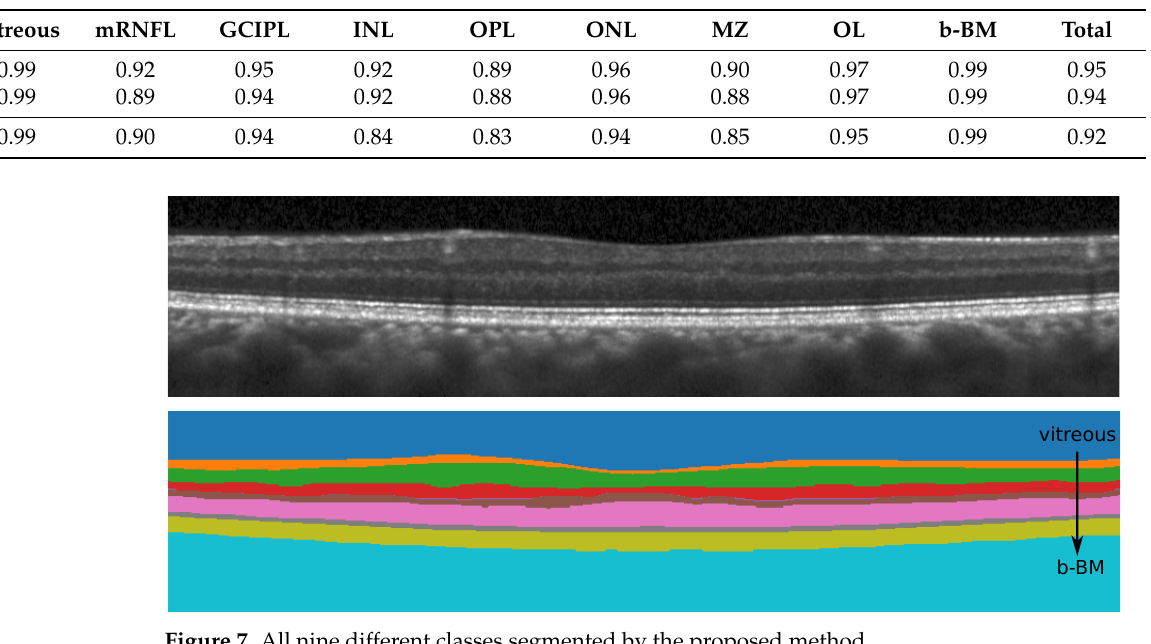
Figure 7. All nine different classes segmented by the proposed method.